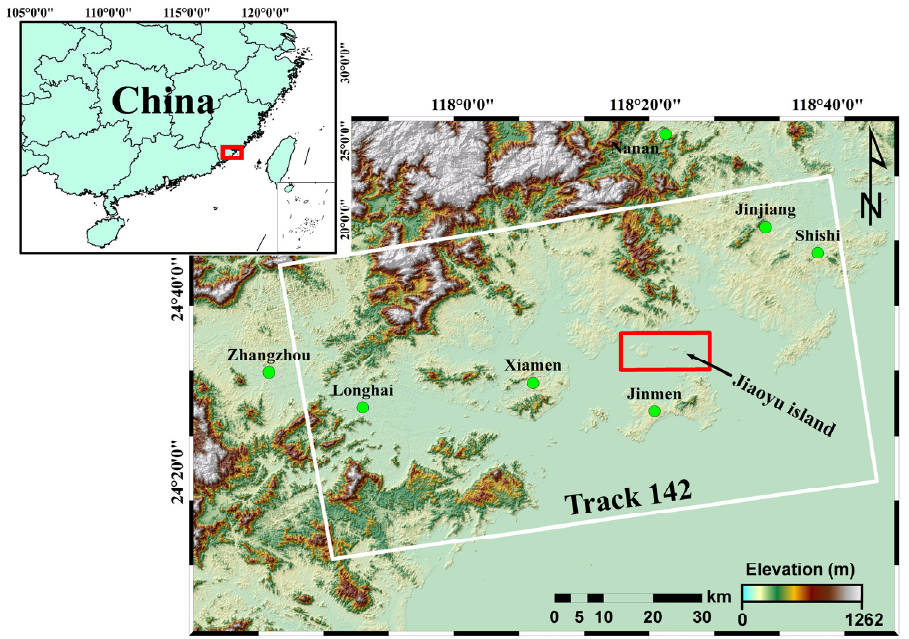
Figure 1. Study area location and synthetic aperture radar (SAR) data coverage. The background is the shaded topography generated from the shuttle radar topography mission digital elevation model (SRTM DEM), where the coverage of Sentinel-1 SAR data is superimposed by the white rectangle, green dots indicate the location of the major cities, and the red rectangle indicates the location of the study area. Inset indicates the study-area location in China.